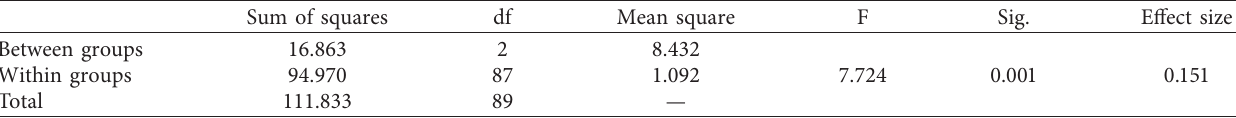
Table 6: Results of one-way ANOVA for writing complexity.